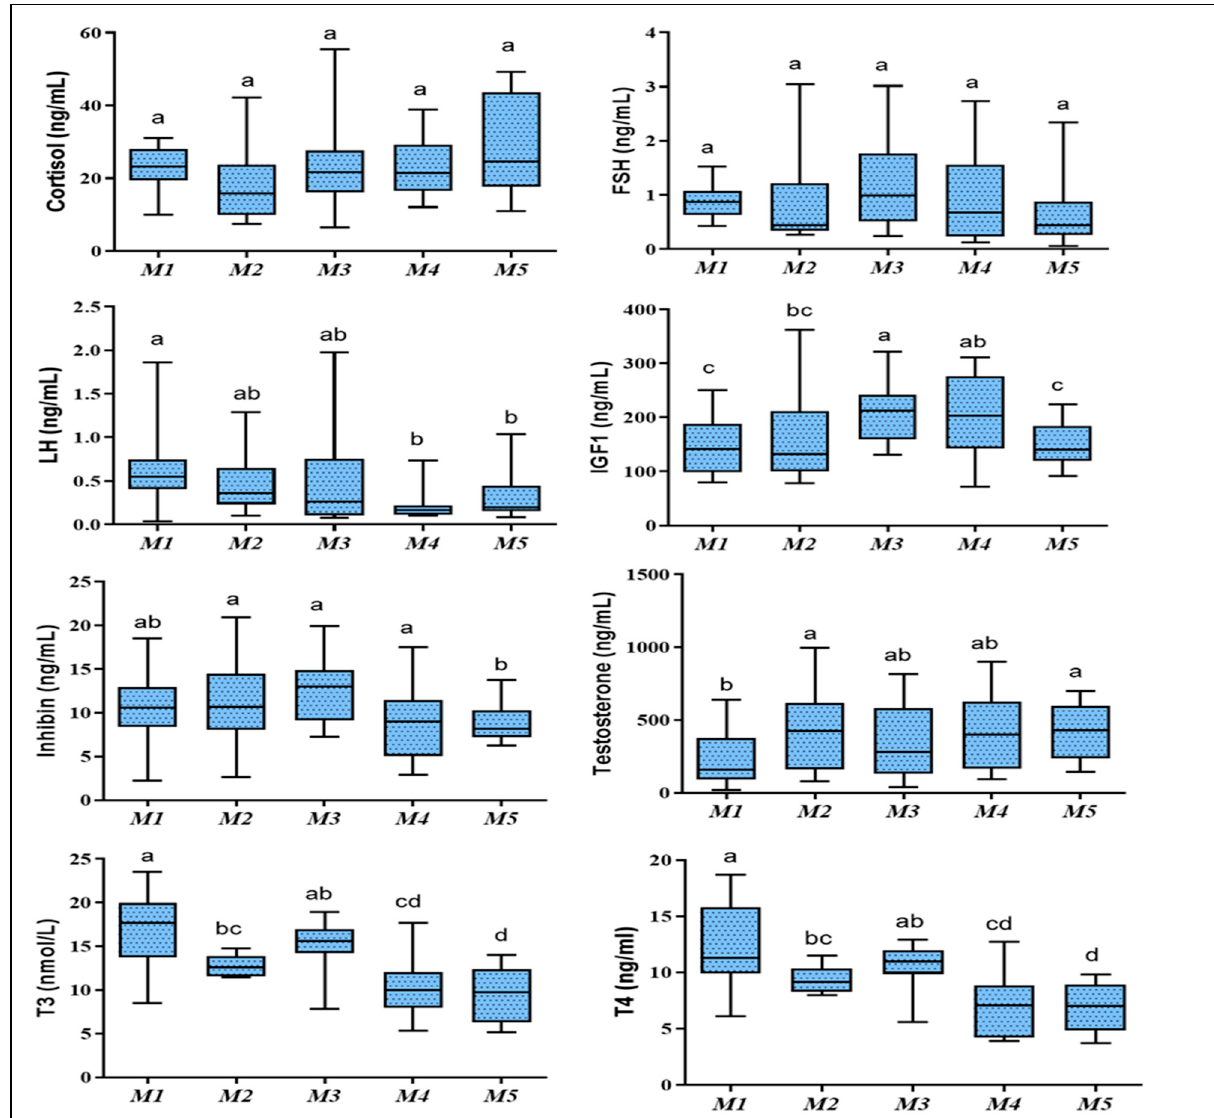
Figure 2. Whisker box plots showing the median and range of plasma hormone concentrations in newborn goat’s kids during the first five months of life. Different letters indicate a significant difference between ages per month ( p < 0.05). FSH, follicle-stimulating hormone; LH, luteinizing hormone; IGF1, insulin-like growth factor 1; T3, triiodothyronine; T4, tetraiodothyronine.